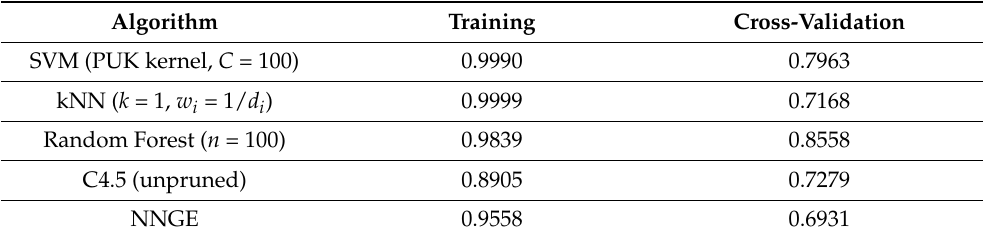
Table 1. Results of classification algorithms to predict the VFI parameter based on glaucoma risk factors.